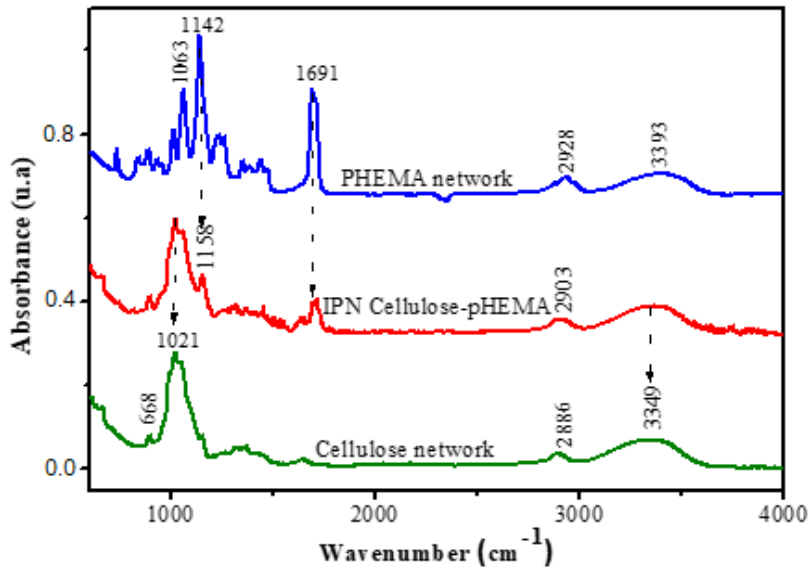
Figure 5. FTIR spectra comparing cellulose hydrogel, PHEMA hydrogel and IPN b (cellulose/PHEMA, 10/90, ECH = 7%).